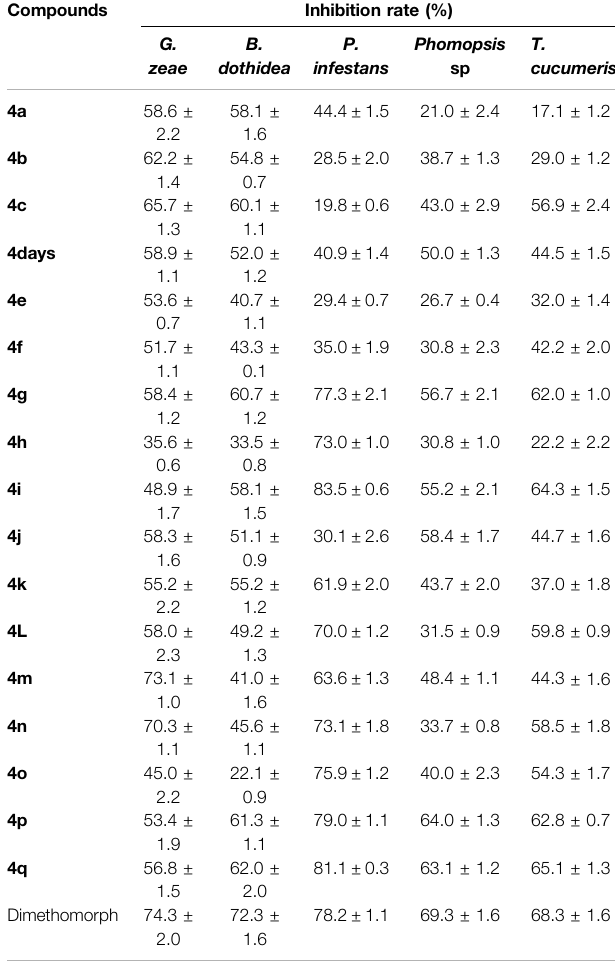
TABLE 1 | The in vitro antifungal activities of the target compounds 4a – 4q at 50 μ g/ml.